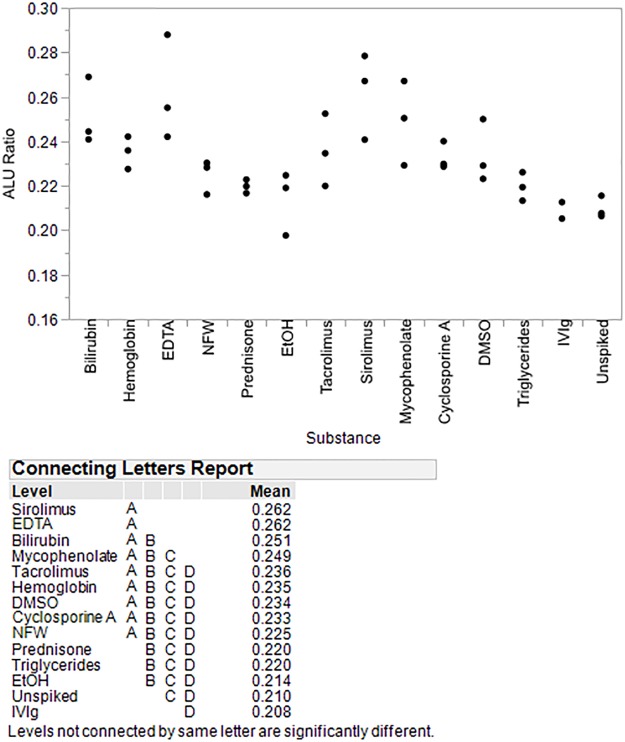
Interfering substance results at 25 ng/ml total cfDNA (TCF), DNA fragmentation assay, one-way analysis of Alu ratio with connecting letters report.At this TCF concentration, small, but statistically significant differences compared to the unspiked controls, but not compared to diluting solvent controls, were seen for Sirolimus, EDTA, and bilirubin. These findings, in concert with those at lower and higher cfDNA concentrations, indicate lack of clinically relevant effects of these substances on the DNA Fragmentation Assay (see text).